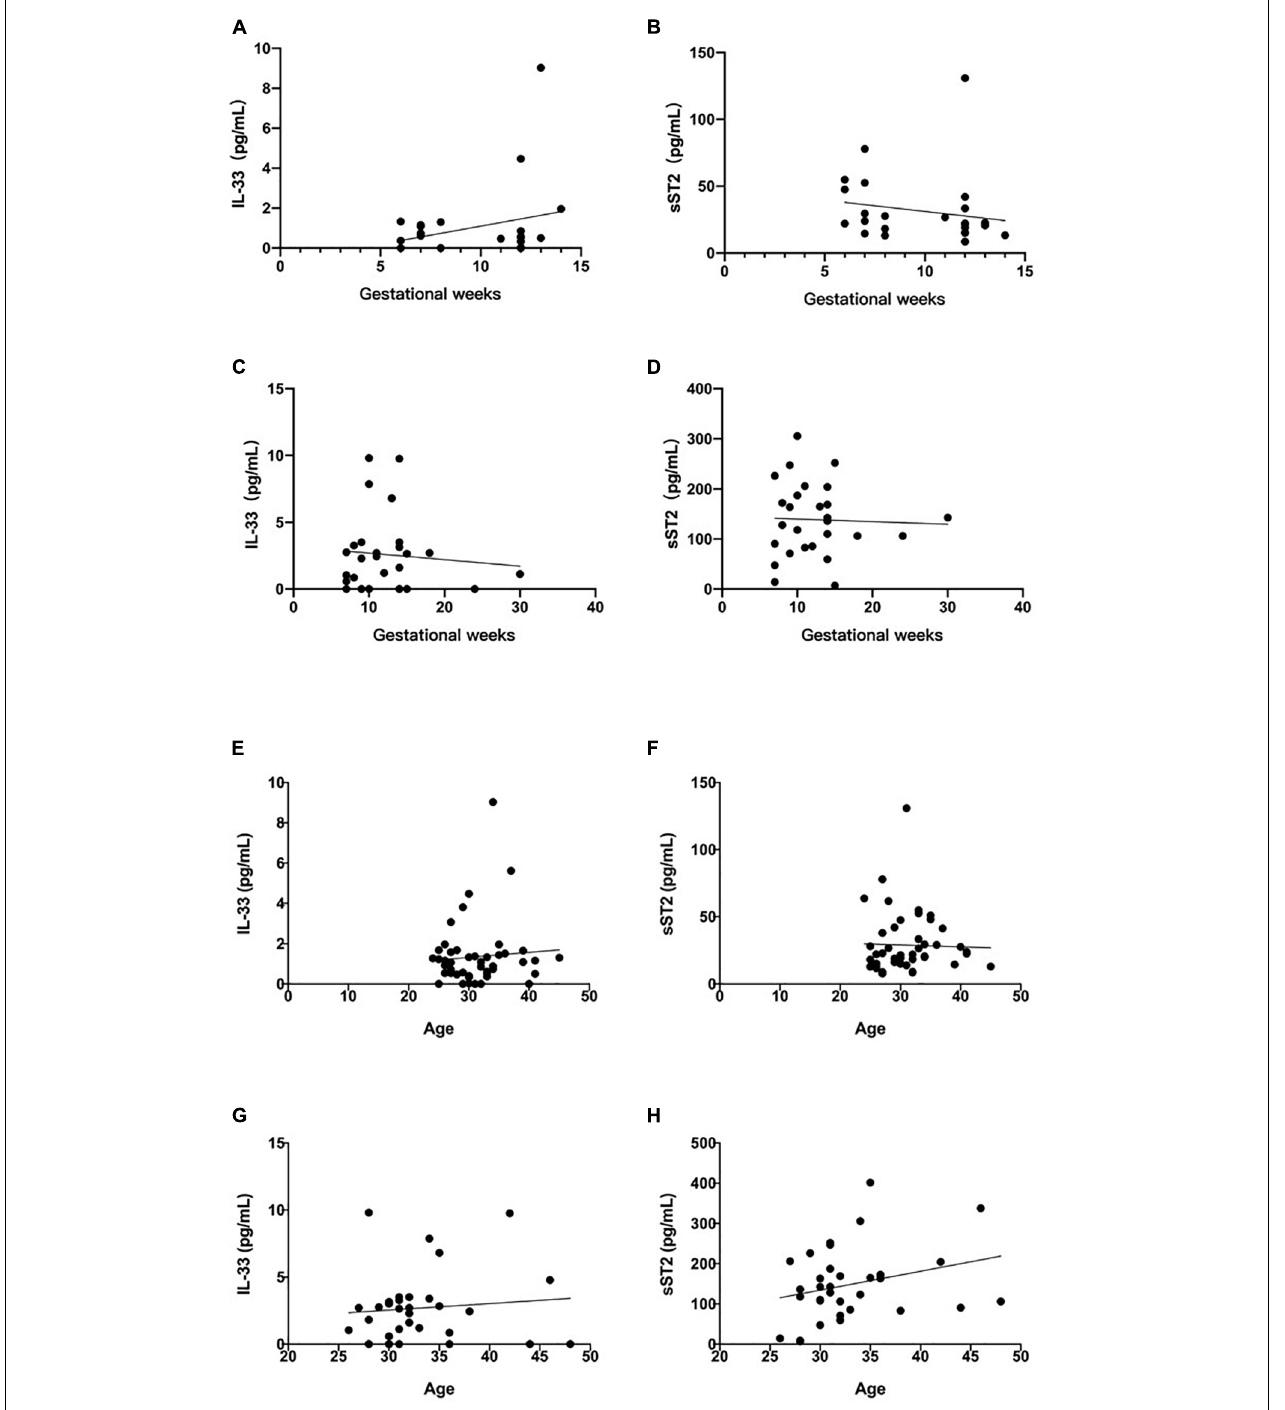
FIGURE 3 | Relationship between maternal serum IL-33 and sST2 level and gestational age. (A) Correlation between serum IL-33 and weeks of gestation in normal pregnancy group. (B) Correlation of soluble ST2 with the number of weeks of gestation in normal pregnancy group. (Values corresponding to the same number of weeks of gestation are plotted using their mean values). Relationship between maternal serum IL-33 and ST2 level and gestational weeks. (C) Correlation between serum IL-33 and weeks of gestation in RSA pregnancy group. (D) Correlation of soluble ST2 with the weeks of gestation in RSA pregnancy group. (Values corresponding to the same number of weeks of gestation are plotted using their mean values). Relationship between maternal serum IL-33 and ST2 level and age. (E) Correlation between serum IL-33 and age in normal group. (F) Correlation between serum soluble ST2 and age in normal group. Relationship between maternal serum IL-33 and ST2 level and age. (G) Correlation between serum IL-33 and age in diseased group. (H) Correlation between serum soluble ST2 and age in diseased group.